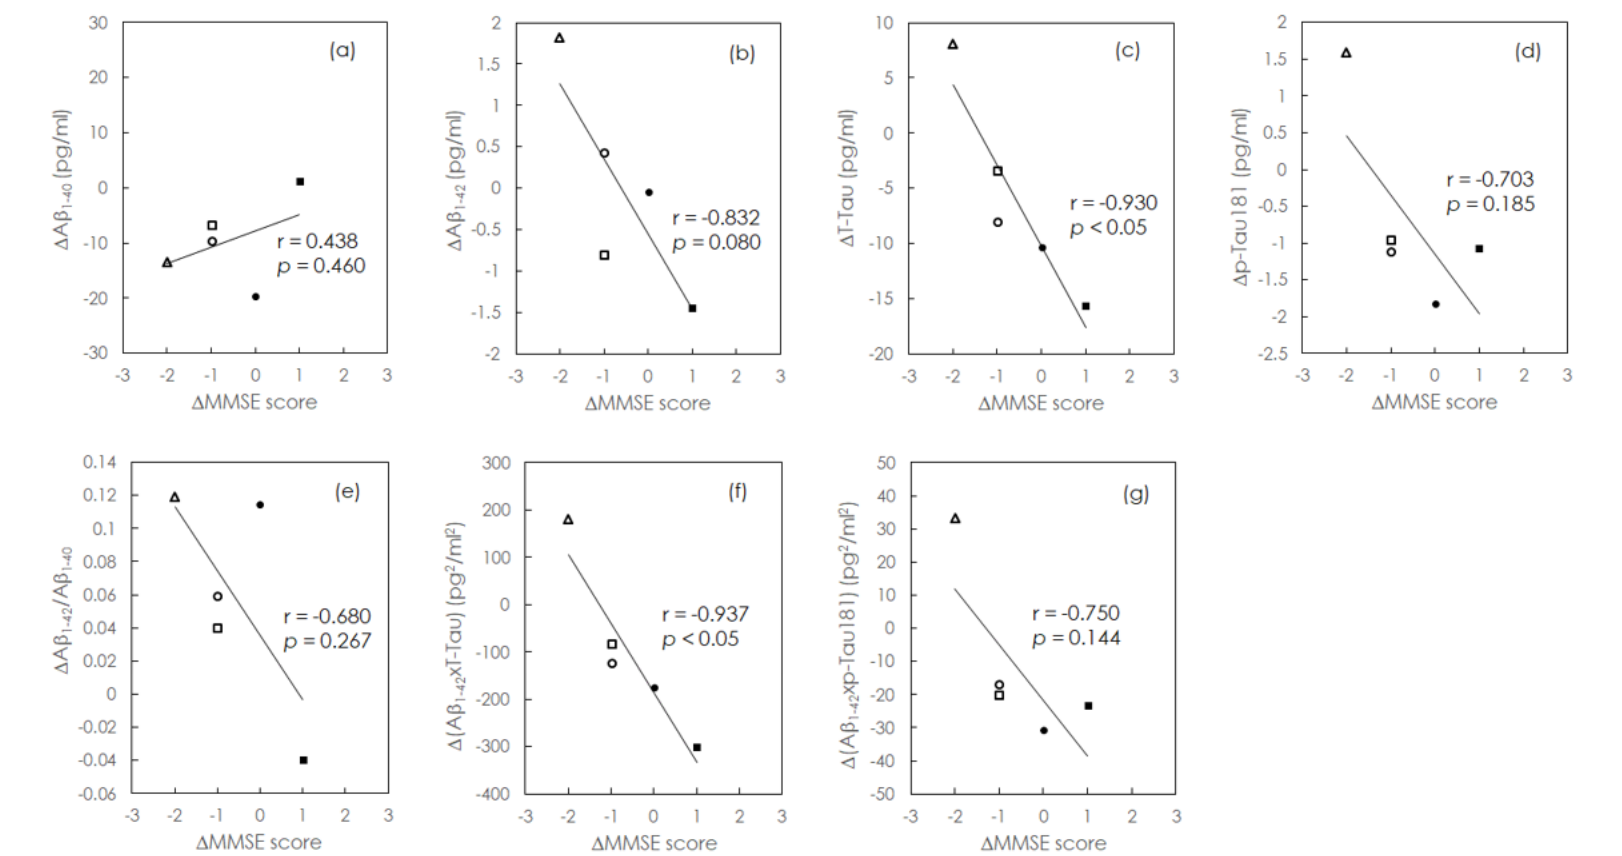
Figure 2. Changes in individual and combined plasma biomarkers for two AD patients ( and ) and three aMCI patients ( , , and ). Levels of ( a ) A 1-40 , ( b ) A 1-42 , ( c ) 38 t-Tau, ( d ) p-Tau181, ( e ) A 1-42 /A 1-40 , ( f ) A 1-42 × t-Tau, and ( g ) A 1-42 × p-Tau181 versus changes in MMSE scores for the five individual patients with aMCI ( , , and ) 39 or AD ( and ) in the longitudinal analysis. 40